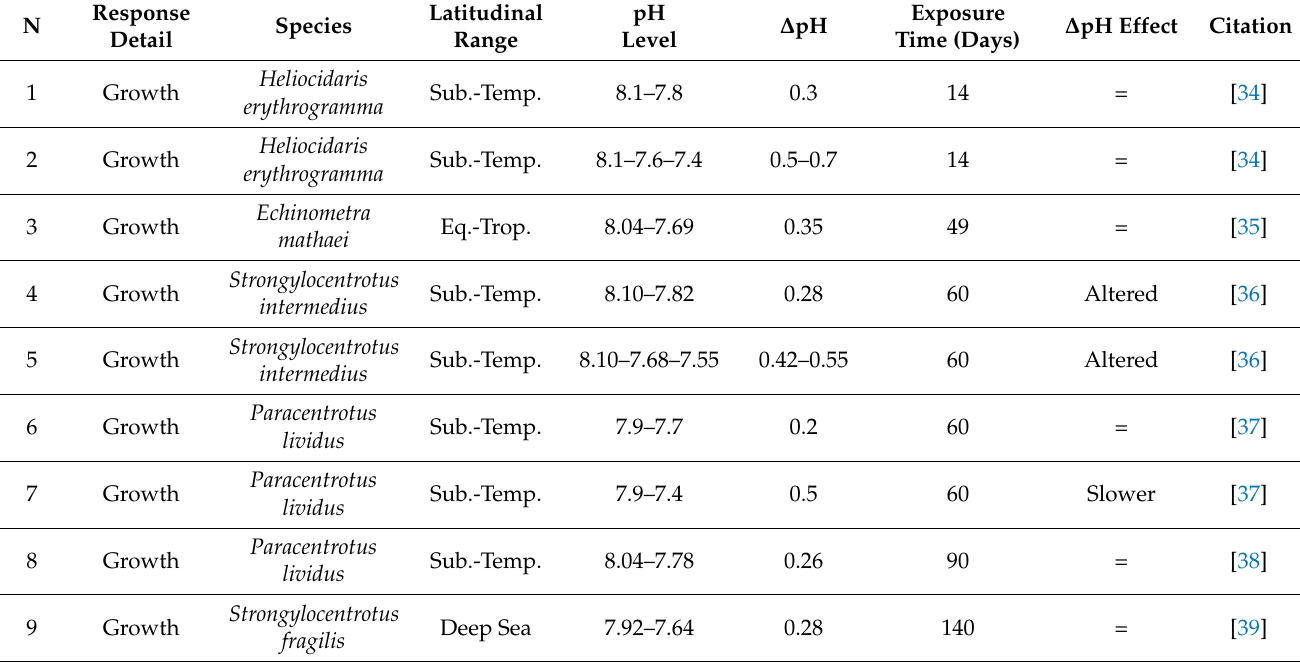
Table 1. List of studies performed on echinoid adult stage to investigate effects of SWA on calcification. “pH level” contains the value of all the conditions tested; the first value is the control. In the case that the same article tested both a realistic ( ∆ pH ≤ 0.4; based on IPCC RCP8.5) and unrealistic scenario ( ∆ pH > 0.4), the two conditions were split. Abbreviations: Eq.-Trop. = Equatorial–Tropical; Sub.-Temp. = Subtropical–Temperate; Temp.-Pol. =